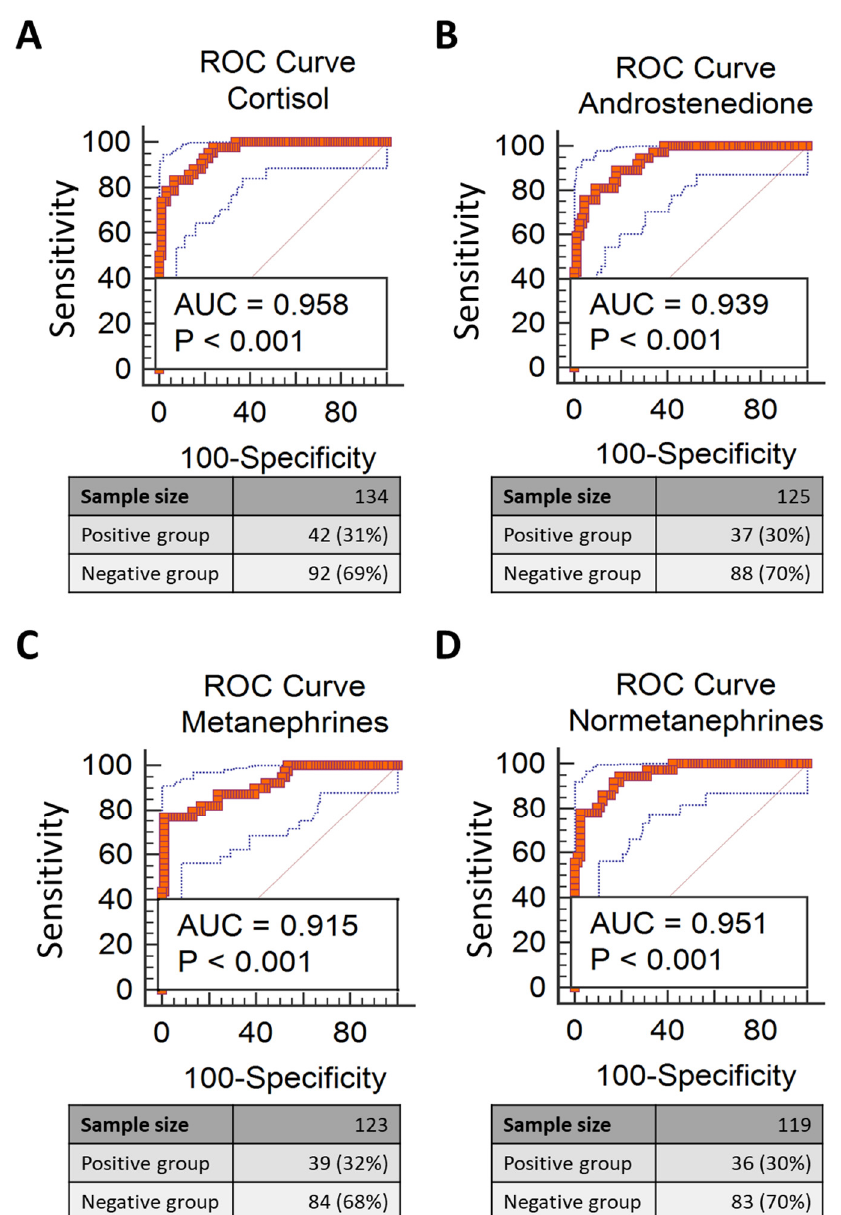
Figure 6. Receiver operating characteristic (ROC) curve of the lateralization index calculated using cortisol ( A ), androstenedione ( B ), metanephrine ( C ) and normetanephrine ( D ) for the identification of unilateral surgically cured PA. Dotted lines represent the confidence bands.